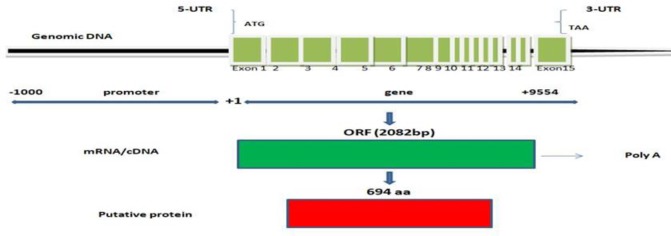
Structure of TORC2 gene, the source of information was (https://www.ncbi.nlm.nih.gov/gene/540959).